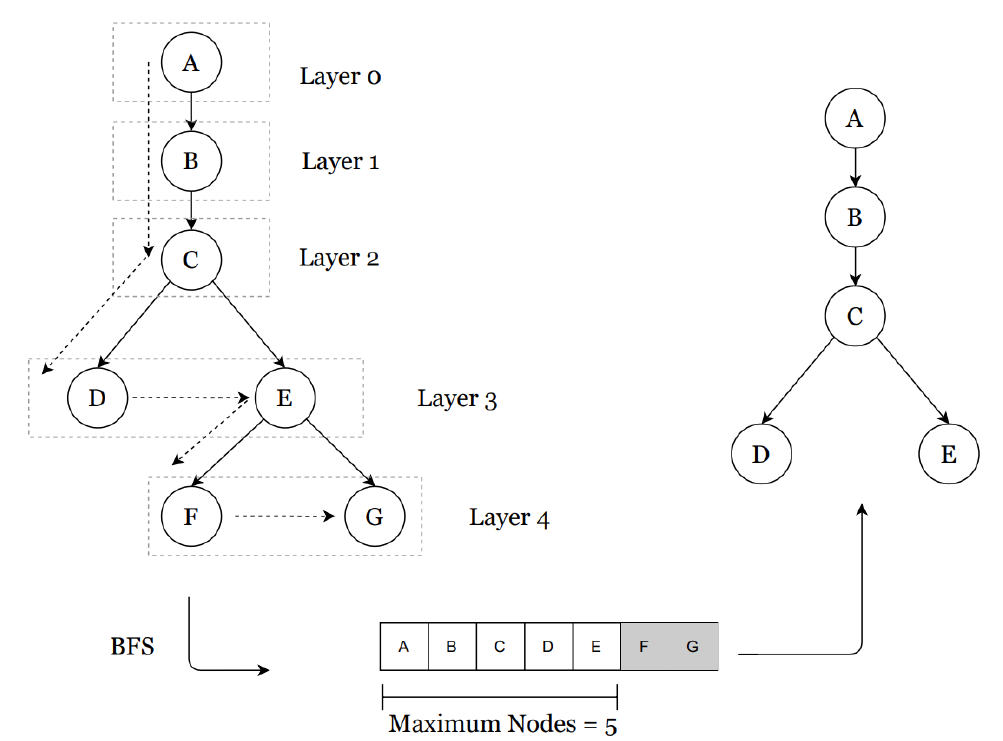
Figure 5. Using the BFS algorithm to trim the AST graph to obtain the minimum number of nodes needed for machine